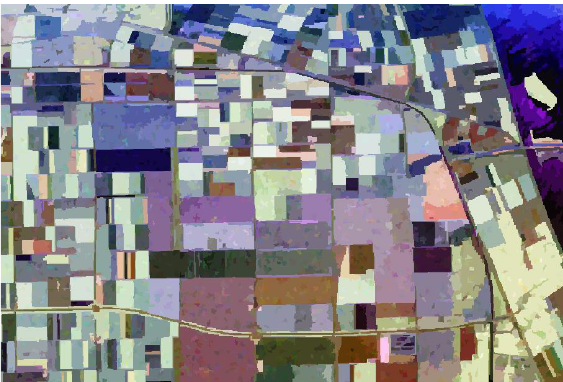
Figure 11. The segmentation result of the Flevoland image using SRM and the original RIU-LBP operator with Q = 250, M = 0.12, N =